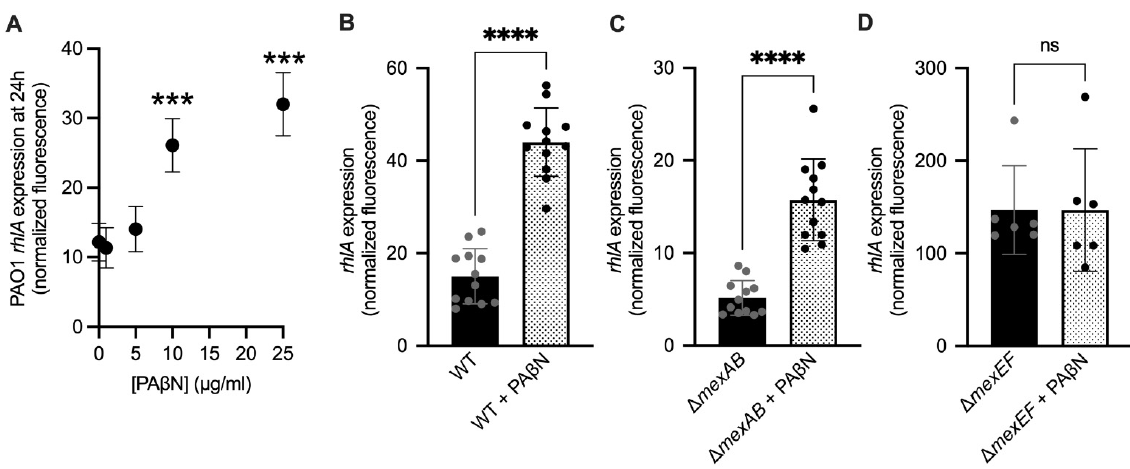
Figure 4. Rhamnolipid gene expression is induced by the Pa β N efflux pump inhibitor. (A) rhlA expression in WT PAO1 attB::rhlA-gfp treated with 0–25 µ g/mL PA β N as measured by GFP fluorescence from the attB::rhlA-gfp promoter reporter fusion at 24 h (*** p < 0.0005, compared 0, 1, and 5 µ g/mL, one-way Brown − Forsythe and Welch ANOVA followed